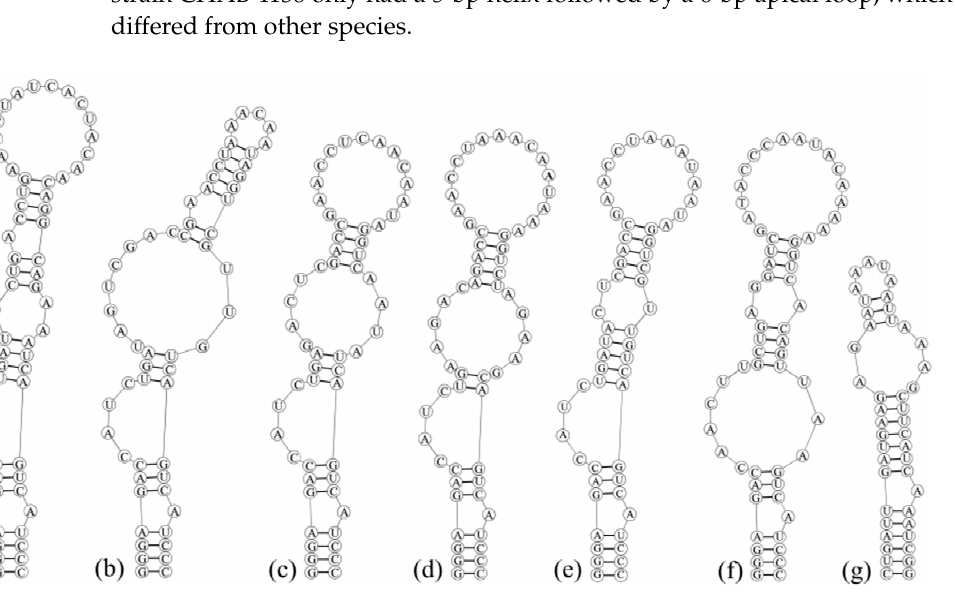
Figure 5. Box–B helix in Microcoleusiopsis ganfuensis and other six related species. ( a ). Microcoleusiopsis ganfuensis CHAB 4138. ( b ). Microcoleus pseudautumnalis AK1609. ( c ). Microcoleus vaginatus CSU-U-KK1. ( d ). Microcoleus vaginatus PTRS-2. ( e ). Microcoleus autumnale SAG 78.79. ( f ) Oscillatoria princeps CCALA 1115. ( g ). Coleofasciculu chthonoplastes MEL. Figure 6. V3 helix in Microcoleusiopsis ganfuensis and other six related species. ( a ). Microcoleusiopsis ganfuensis CHAB 4138. ( b ). Microcoleus pseudautumnalis AK1609. ( c ). Microcoleus vaginatus CSU-U-KK1. ( d ). Microcoleus vaginatus PTRS-2. ( e ). Microcoleus autumnale SAG 78.79. ( f ) Oscillatoria princeps CCALA 1115. ( g ). Coleofasciculu chthonoplastes MEL.